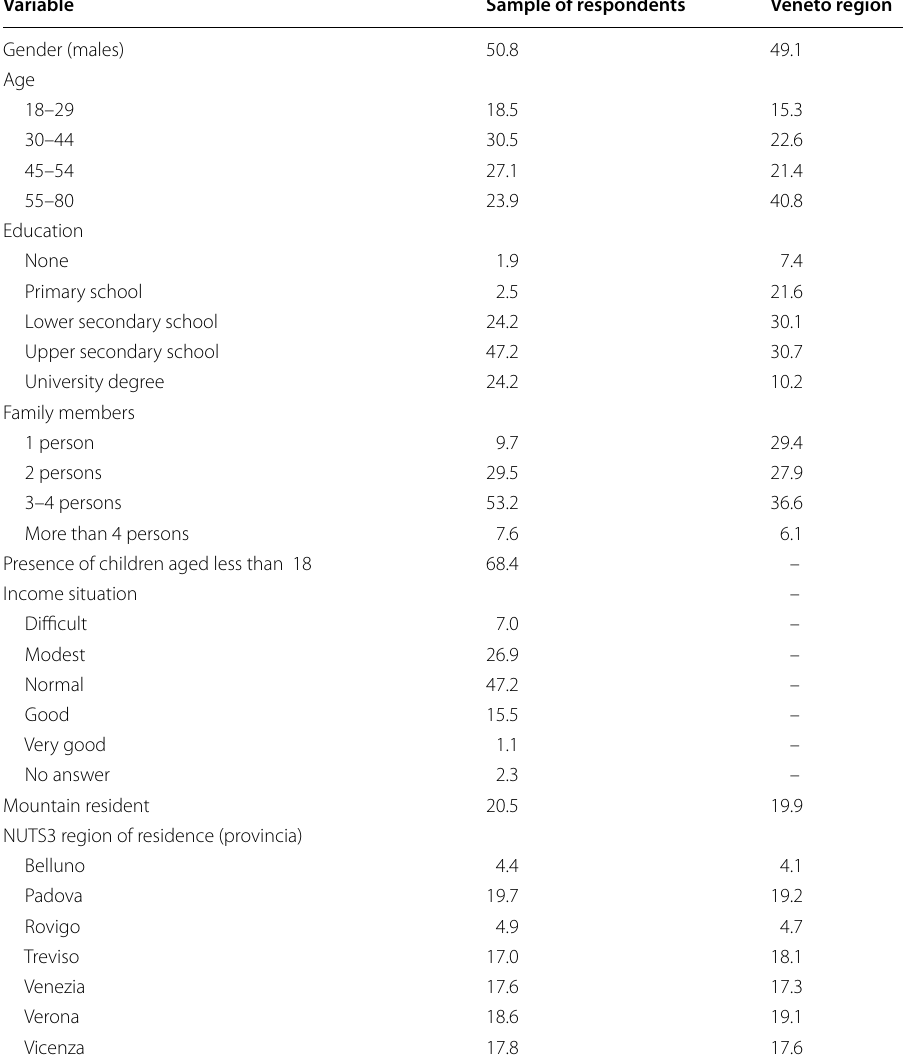
Table 2 Socio-demographic characteristics of the sample and in the Veneto region (percentage values)